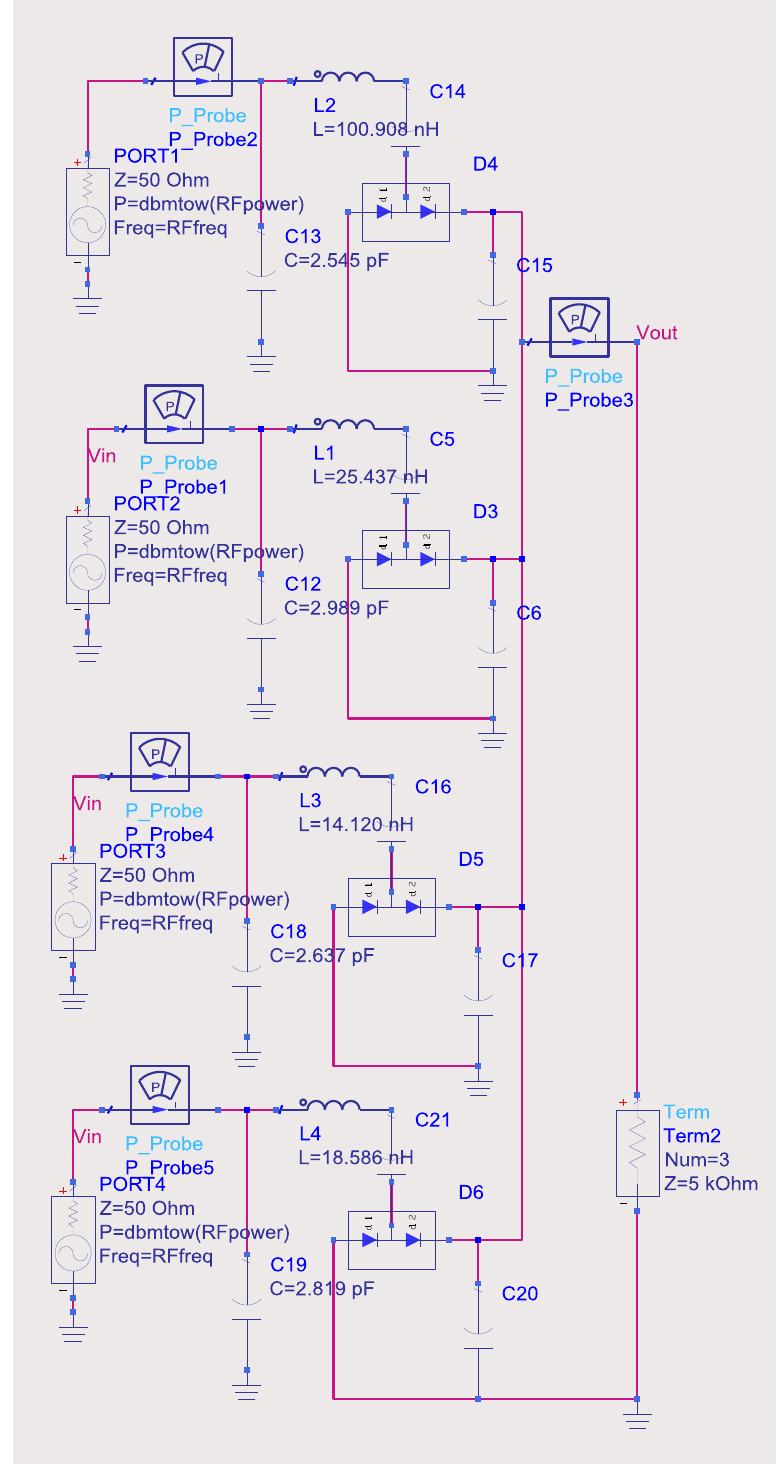
Figure 7. The proposed quad-band circuit with four receiving